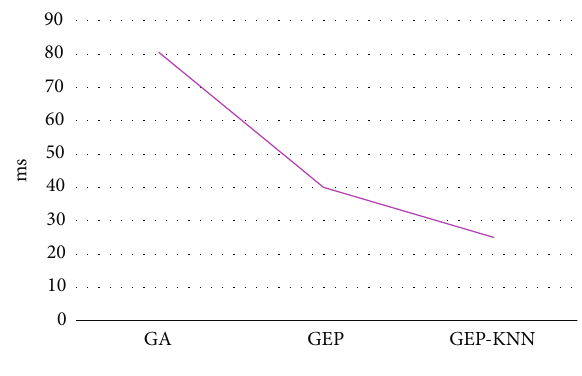
Figure 3: Computation